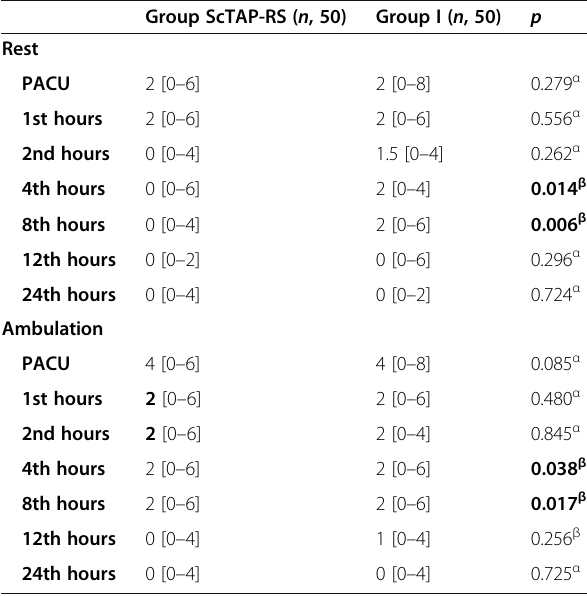
Table 2 The comparison of postoperative VAS values in rest and ambulation between group ScTAP-RS and group